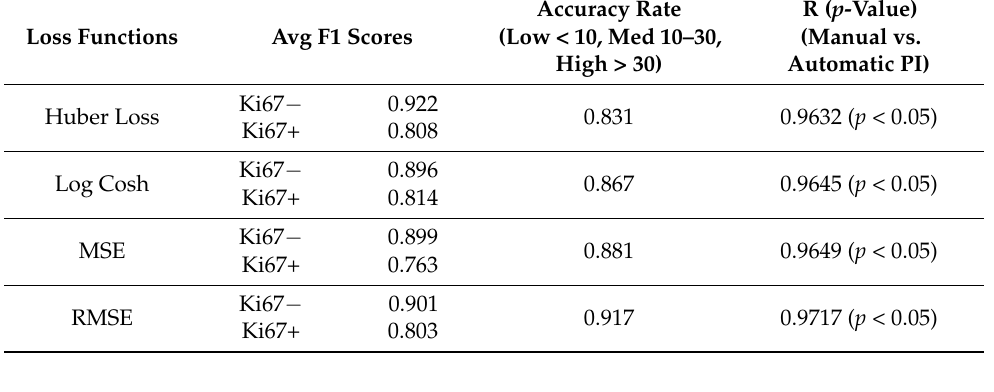
Table 3. Average F1 scores, accuracy rates and R values of SMH patches per loss function.